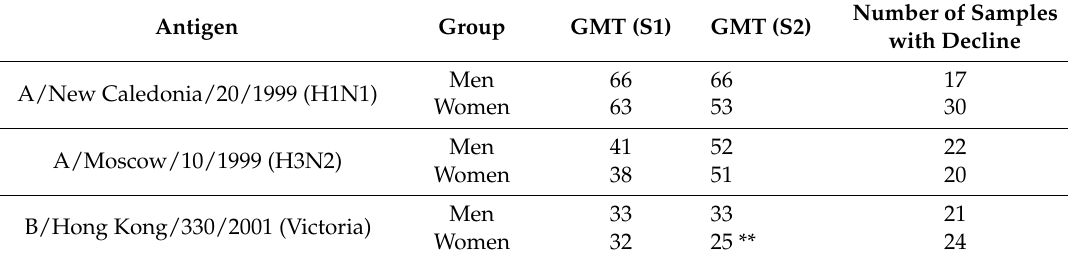
Table 3. HI Data for the 2011 Cohort. The names of the antigens used in the HI assay are listed in the first column. The geometric mean titers immediately after vaccination (S1) and later in the year (S2) are shown for each antigen for each group (Men or Women). The p -values for significant changes in GMTs between S1 and S2 (Mann Whitney rank test) are indicated by asterisks: ****, p < 0.0001; *, p < 0.05. The number of samples for each group of 80 that had a decrease in titer is shown in the last column. Antigen Group GMT (S1) GMT (S2) A/California/07/2009